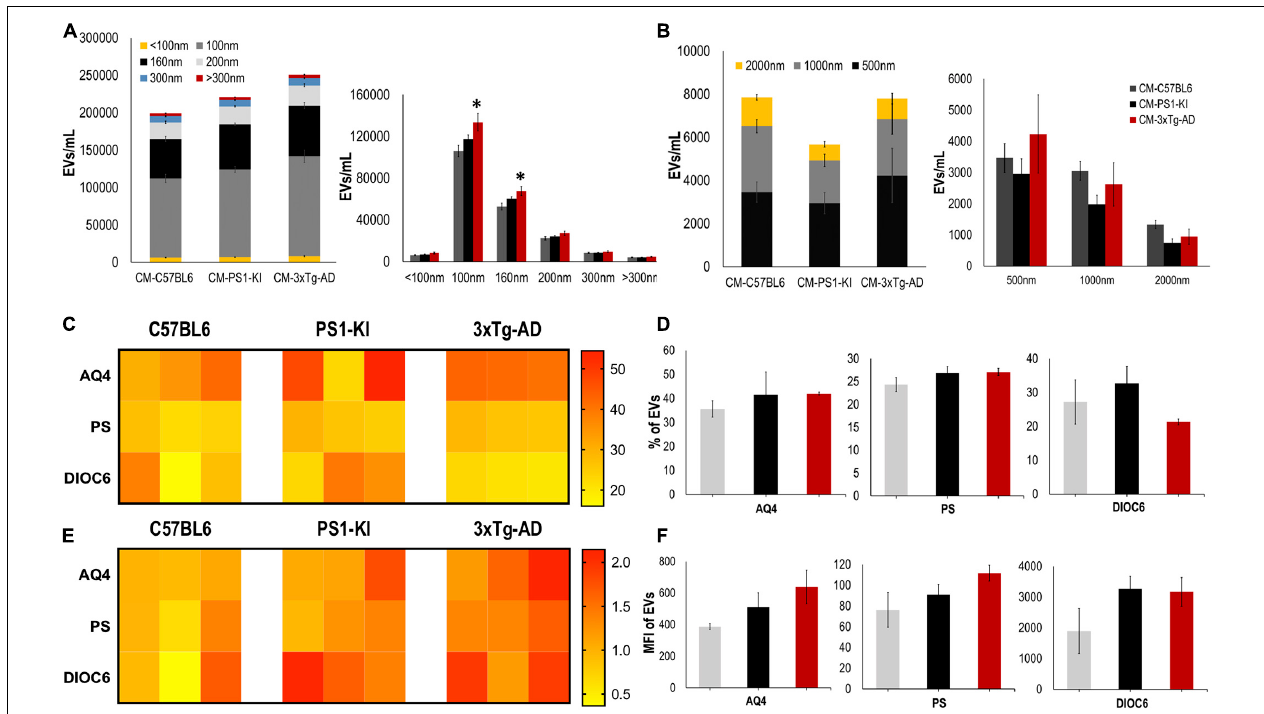
FIGURE 3 | 3xTg-AD mice have an increase in A-EVs. (A) Quantification and distribution of EVs numbers from CM treatment according to diameter ( < 100 and 100 nm: exosomes; 160, 200, and 300 nm: MVs). Significant differences in the number of 100 nm exosomes and 160 nm MVs in 3xTg-AD astrocytes compared with that in the C57BL6 samples. P -value significance *0.05. n from 4 to 8. (B) Quantification and distribution of EVs numbers from CM treatment according to diameter (500; 1000; and 2000 nm). No significant differences in the number of EVs in 3xTg-AD astrocytes compared with that in the other samples. n from 4 to 8. (C) Heatmap of percentages of EVs positive for cell markers (AQ4, astrocyte; Annexin, phosphatidyl-serine and DIOC6, mitochondria) from each astrocyte group. (D) Comparative of percentages of EVs positive of cell markers for grouped data seen in panel (C) . (E) Heatmap of the normalized MFI of cell markers (to mean data from C57BL6 individuals). (F) Comparative of MFI of cell markers for grouped data seen in panel (E) . Representative data from n = 3. Data were plotted as means and SEM. Kruskal–Wallis test and Dunn’s multiple comparison test. ∗ Indicates p < 0.05; ∗∗ indicates p < 0.01.